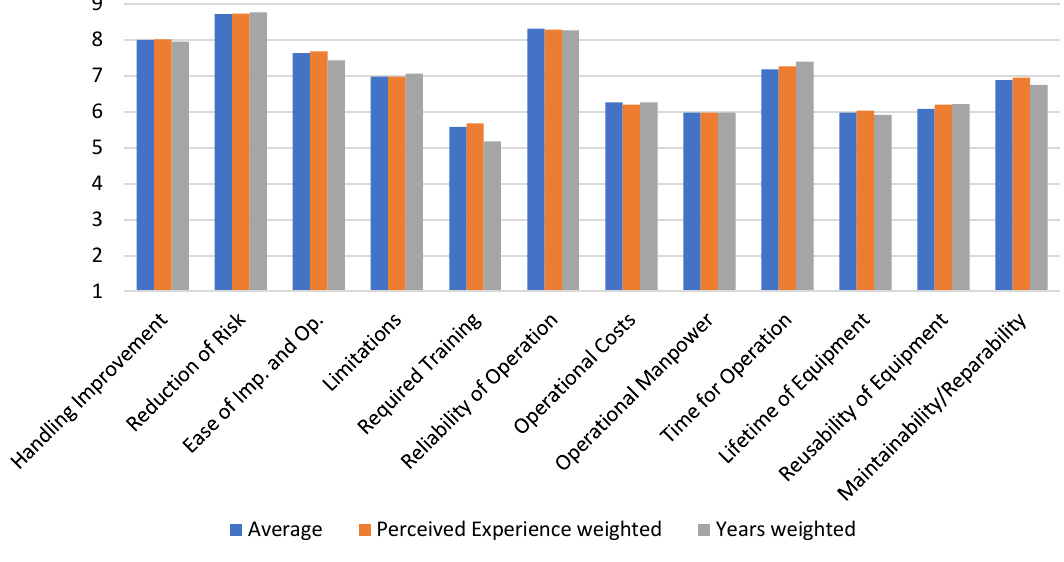
Figure 8. Averaged responses to the section ‘Operational’.